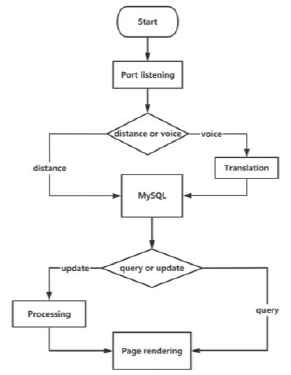
Figure 6. The workflow chart of the cloud information management platform.